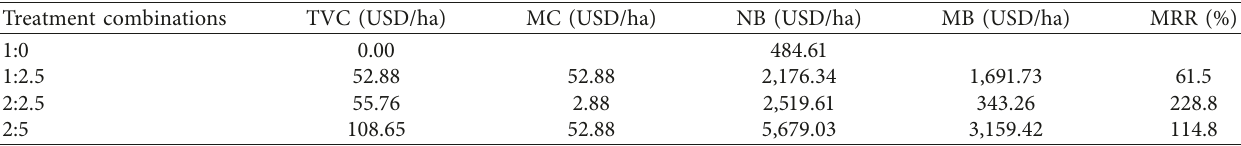
Table 5: Marginal rate of return (MRR) of cabbage yield as affected by bud number and farmyard manure fertilizer rates in northwestern Ethiopia. Treatment combinations TVC (USD/ha)